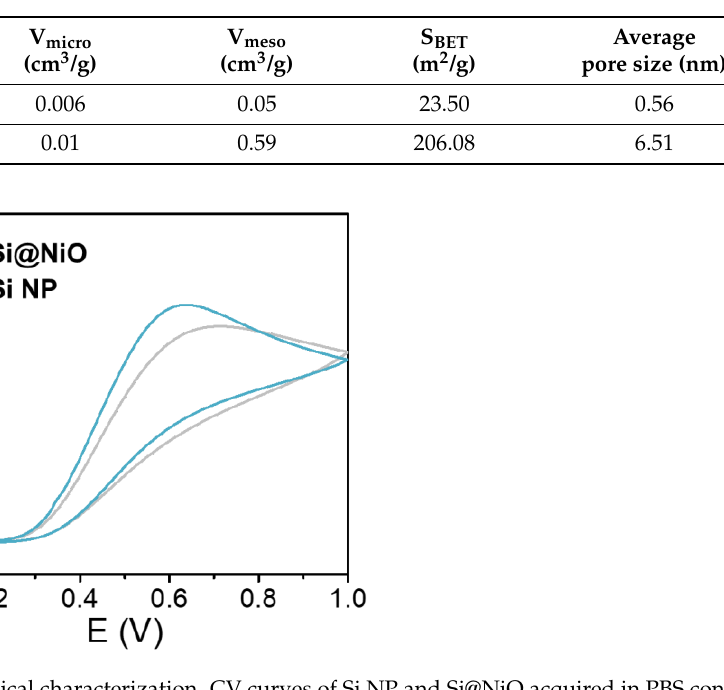
Figure 5. Metal ion release from Si@NiO nanoflowers. Concentration of Ni ions released from 1 mg/mL of Si@NiO in 0.9% saline solution. 3.6. Anticancer Properties and Cytotoxicity The most important requirements of cancer therapeutics are efficacy and selective toxicity [58,59]. The ability of a drug to induce cancer cell apoptosis without affecting nor- mal cells is the key requirement for effective cancer treatment. Since the active metal ions on the surface of metal oxide nanoflowers can actively participate in ROS formation through oxidation, these nanoflowers have great potential as a therapeutic for cancer treatment. Moreover, as the metal ion release is not sufficiently high enough, this aspect should not affect the anticancer activity remarkably. Nonetheless, it is important to deter- mine the cytotoxicity of Si@NiO nanoflowers on normal cells and cancer cells. The MCF-